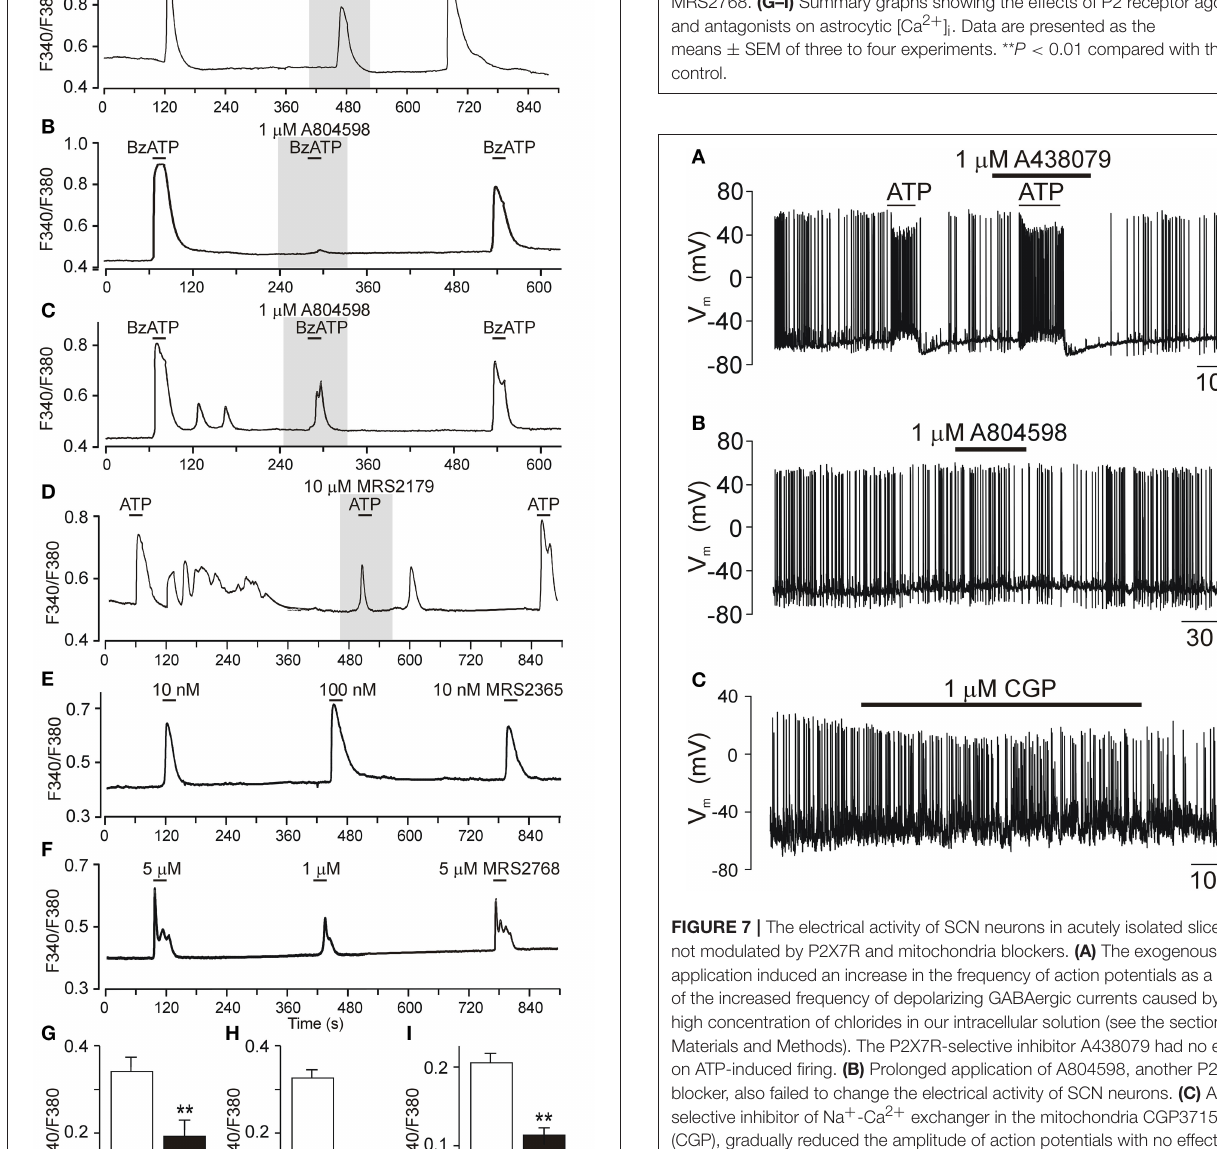
FIGURE 6 | the P2Y1R-selective blocker MRS2179. (E) Concentration- dependent elevation of astrocytic calcium levels by the P2Y1R agonist MRS2365. (F) Concentration-dependent effect of the P2Y2R agonist MRS2768. (G–I) Summary graphs showing the effects of P2 receptor agonists and antagonists on astrocytic [Ca 2 + ] i . Data are presented as the means ± SEM of three to four experiments. ** P < 0.01 compared with the control.